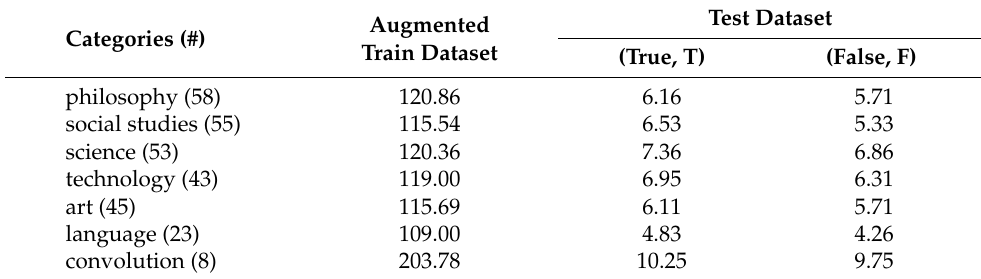
Table 2. Main categories and their average number of sentences (in parentheses, marked #) in reading.